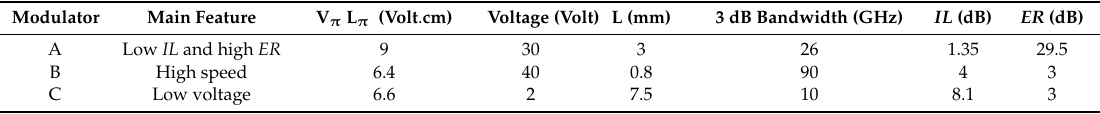
Table 1. Summary of the proposed structures.